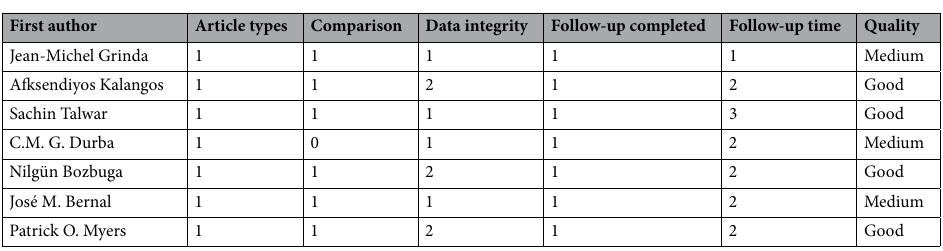
Table 2. Quality assessment of each